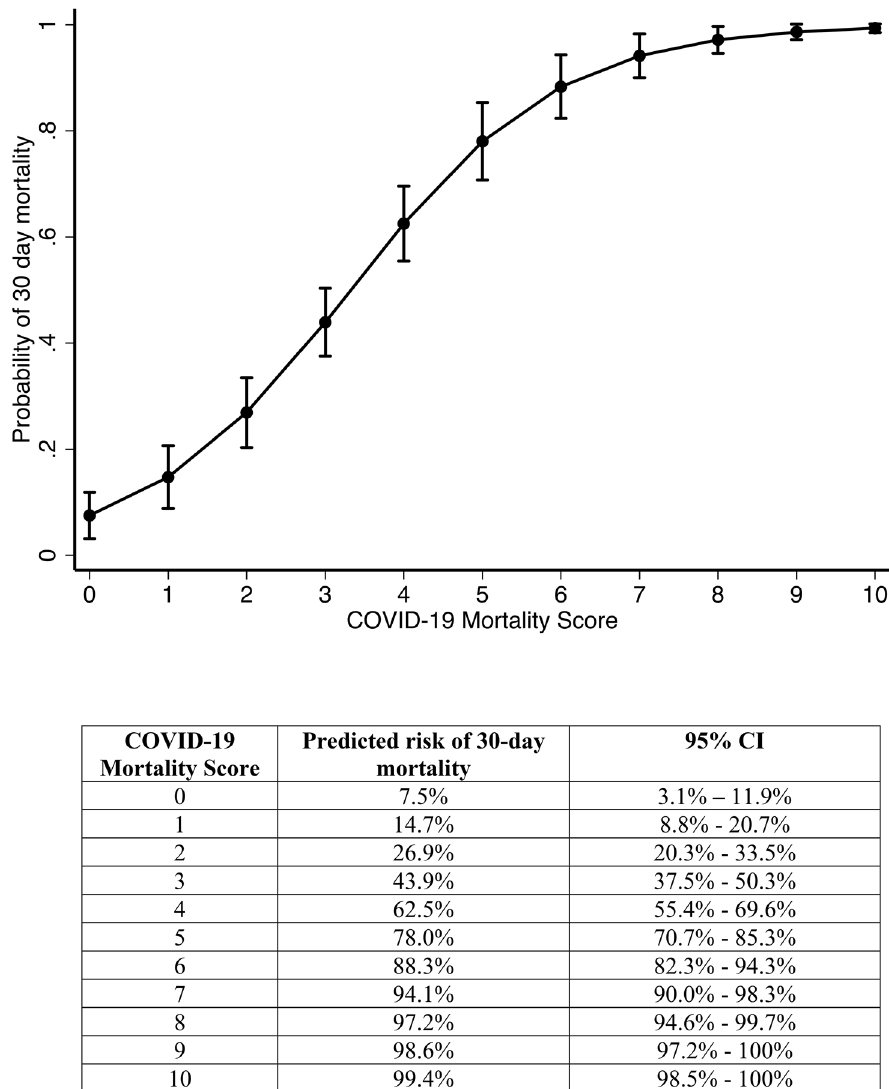
Figure 1. The COVID-19 mortality score adjusted prediction of 30-day mortality, with 95% CI.